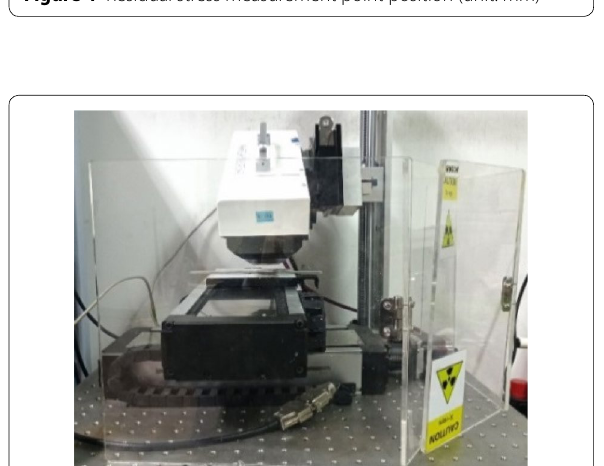
Figure 5 μ-X360 X-ray diffractometer